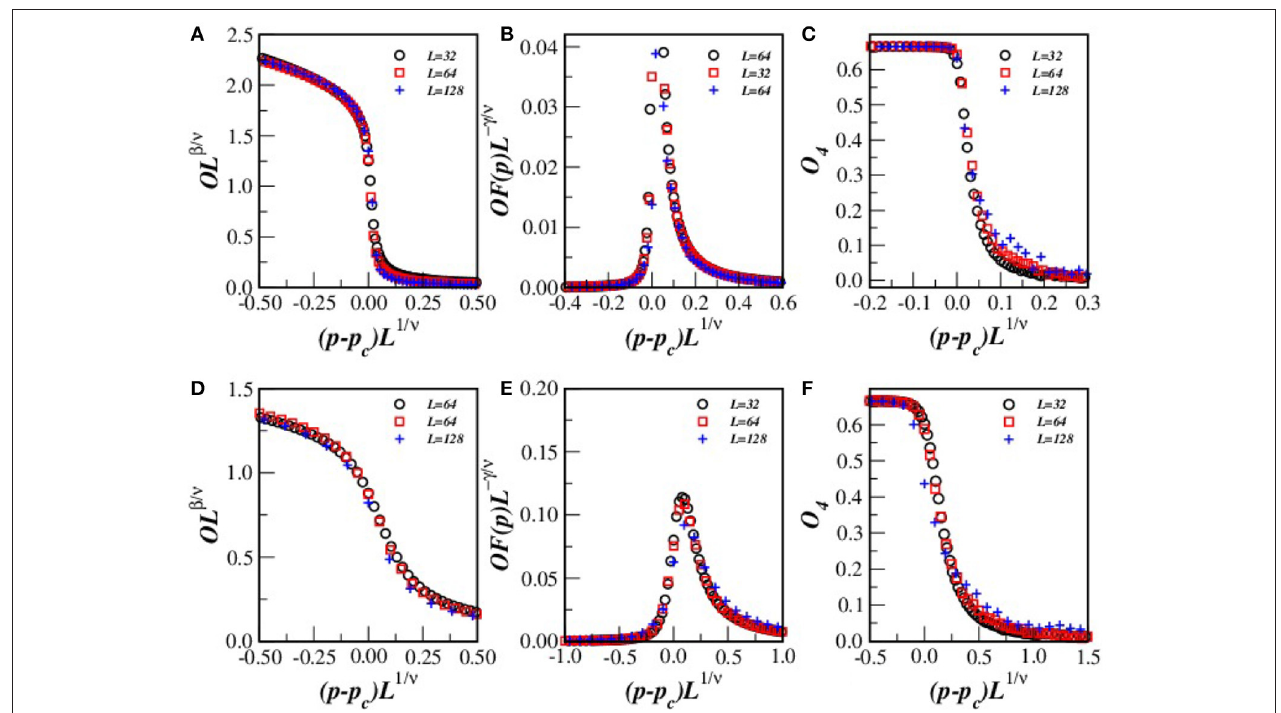
FIGURE 7 | (Color on-line) Data collapse of the opinion O , OF , and O 4 shown in Figure 2 for L = 32, 64, and 128 (4,6,12) and (4,8 2 ) AL. The exponent ratios used here were β/ν = 0.23(7), γ/ν = 1.43(5), and 1 /ν = 0.60(3) for (4,6,12), and β/ν = 0.149(4), γ/ν = 1.56(4), and 1 /ν = 0.94(4) for (4,8 2 ) AL.